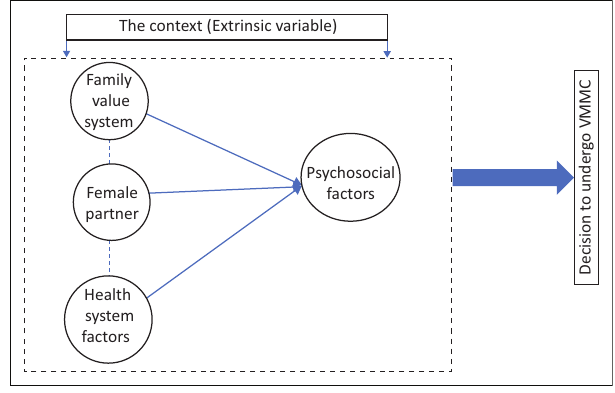
FIGURE 3: Interaction of extrinsic factors.